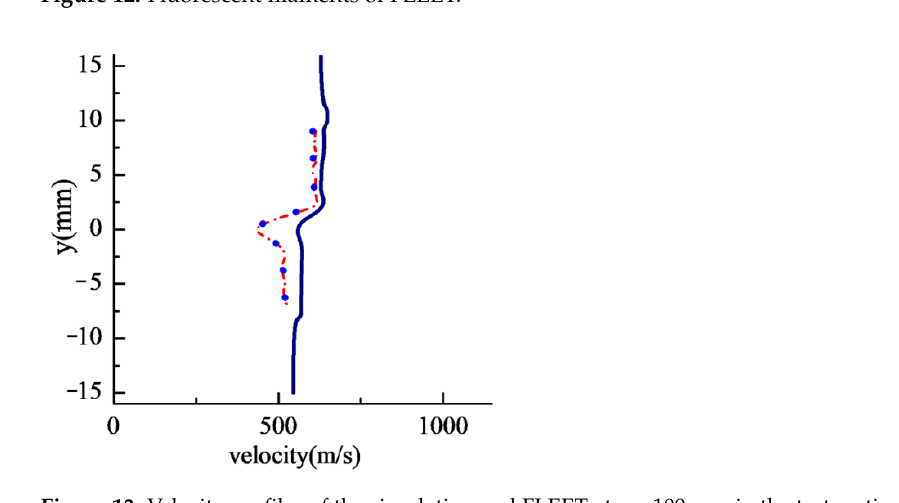
Figure 12. Fluorescent filaments of FLEET.